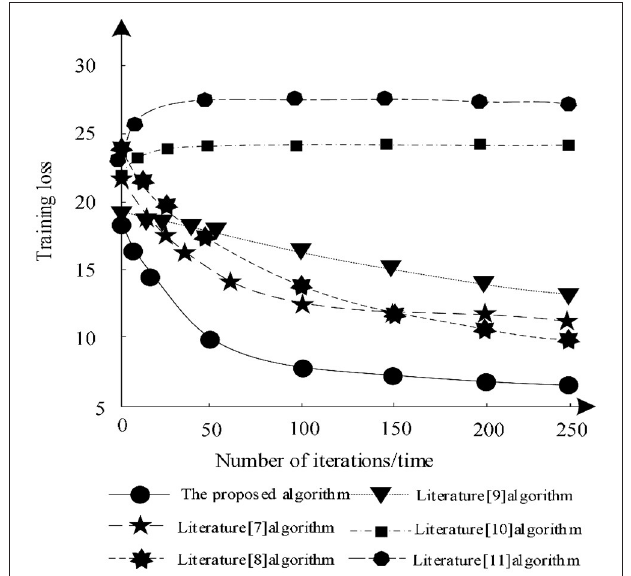
FIGURE 6 | Training loss of different algorithms.